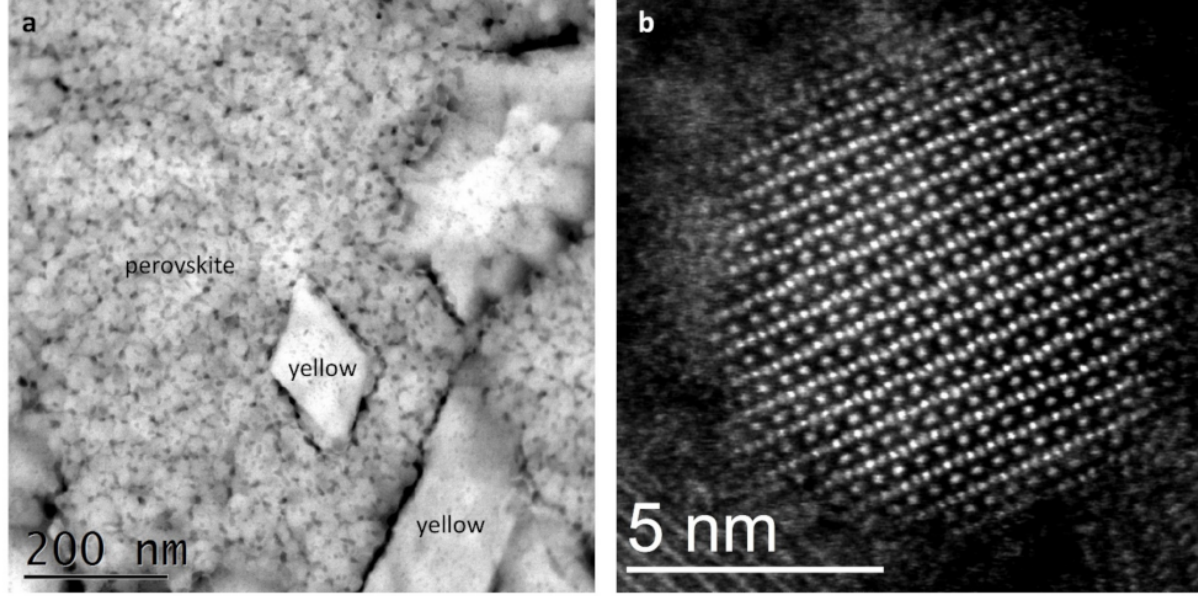
Figure 3. ( a ) STEM image of a γ -CsPbI 3 perovskite thin film with δ -CsPbI 3 yellow phase inclusions; ( b ) High-resolution STEM image of a γ -CsPbI 3 nanograin within a δ -CsPbI 3 thin